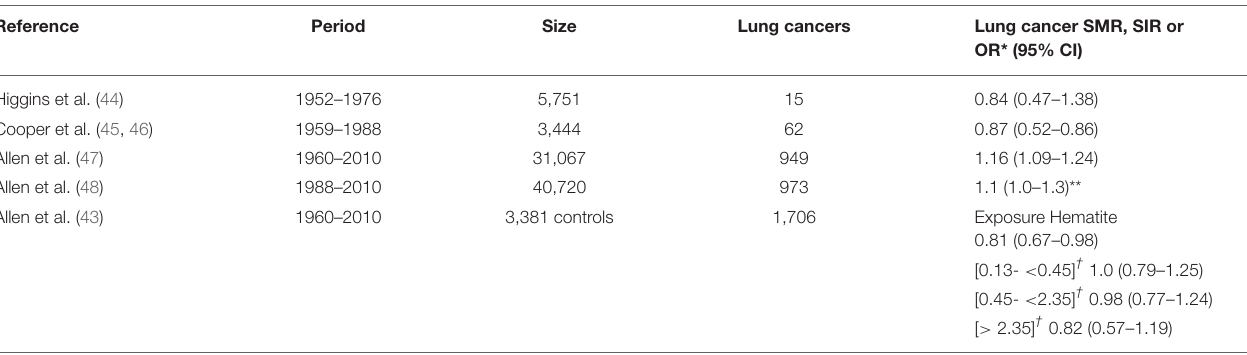
TABLE 3 | Lung cancer results from studies of taconite